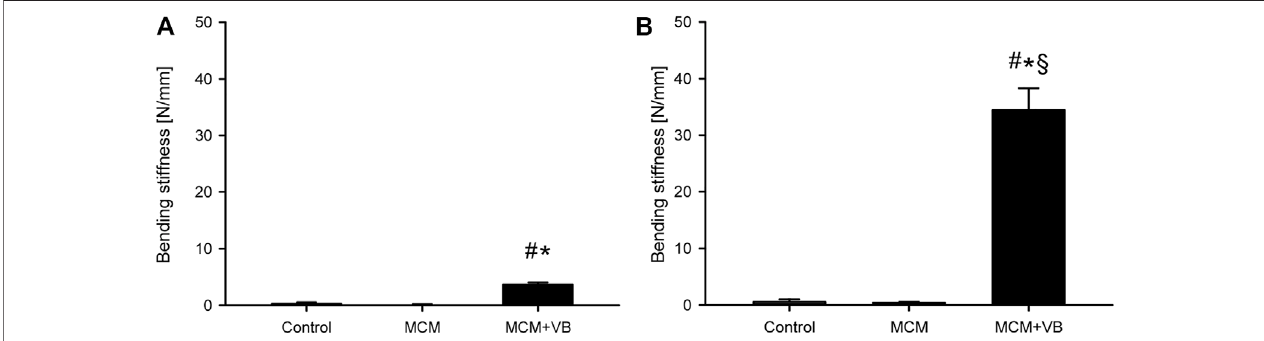
FIGURE3| Biomechanicalanalysisofmousefemurs. A,B: Bendingstiffnessofcontrol( n (cid:1) 8),MCM(n (cid:1) 8)andMCM+VB(n (cid:1) 8)femurs14 days (A) and70 days (B) after osteotomy. Mean ± SEM; # p < 0.05 vs control; * p < 0.05 vs MCM; § p < 0.05 vs MCM + VB at day 14.